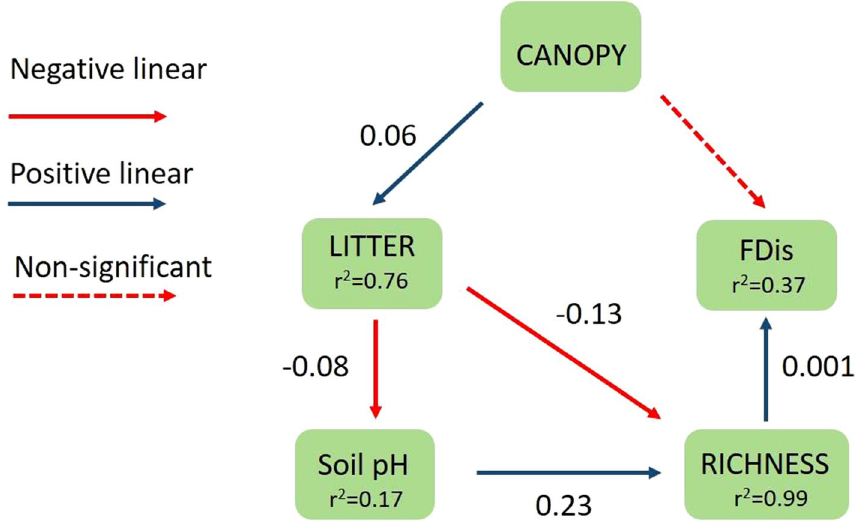
Figure 3. Piecewise SEM model showing the direct and indirect effect of CANOPY (canopy cover), LITTER (leaf litter depth), soil pH and RICHNESS (plant species richness) on alpha functional diversity (FDis). Arrows represent unidirectional relationships among variables and their standardized coefficients are shown ( p < 0.05). Dashed arrow represents nonsignificant relationship ( p > 0.05). R 2 for component models are given in the boxes of response variables.